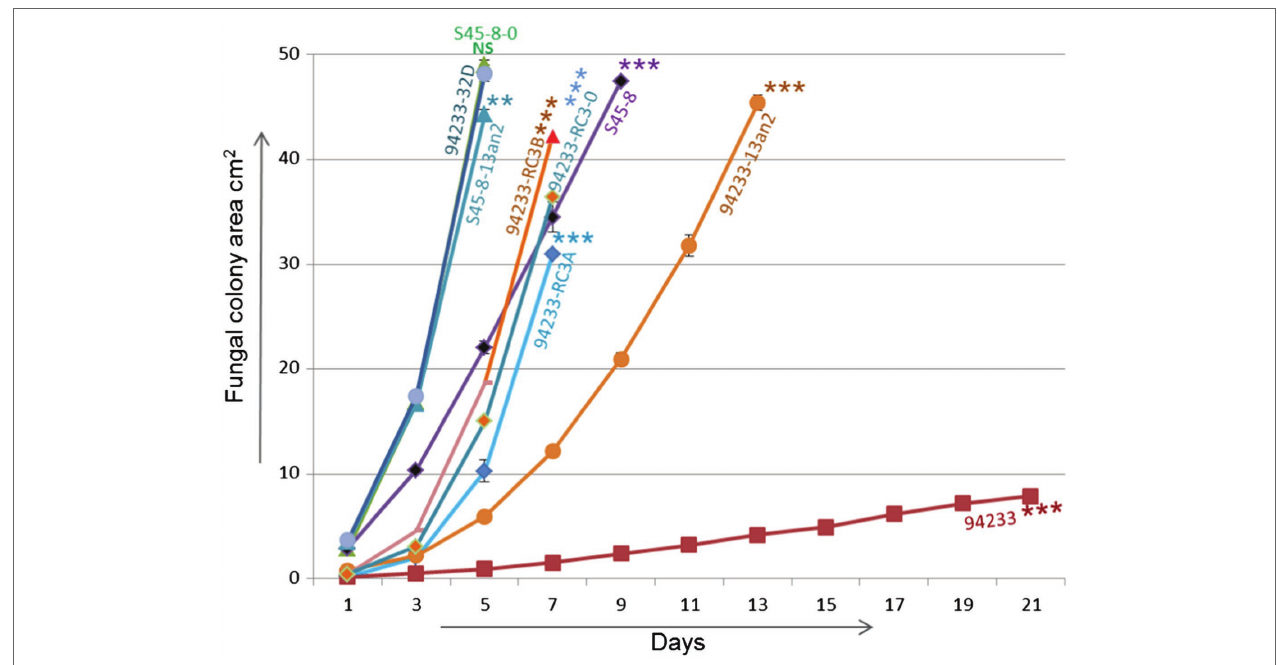
FIGURE 6 | Growth rate analysis. Growth rates of 94233-RC3 and its stored derivative 94233-RC3B infected with HetPV13-an1 including original 94233 with its consistent reduced phenotype and the partitivirus-free control 94233-32D (Kashif et al., 2019). 94233-RC3A = before storage; 94233-RC3B = after storage; 94233 (the original slow-growing strain hosting HetPV13-an1); S45-8-0 = virus-free control; S45-8-PV13an2 (single virus infection HetPV13-an2); S45-8 (the original strain with HetPV13-an2 and HetPV7-an1); and 94233-PV13an2 (HetPV13-an2 hosted by 94233 strain). The significance of the differences between the mean growth per day of the virus-free/cured and virus infected fungal isolates is shown by asterisks: * p < 0.05; ** p < 0.001; and *** p < 0.0001; # = single replicate; NS =